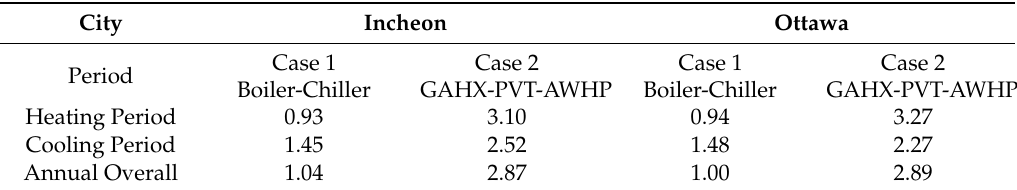
Table 6. Overall system performance (COP).